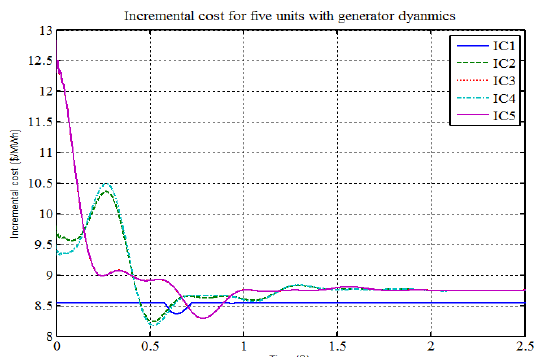
Figure 10. Case study 4: the incremental cost for the five generators.